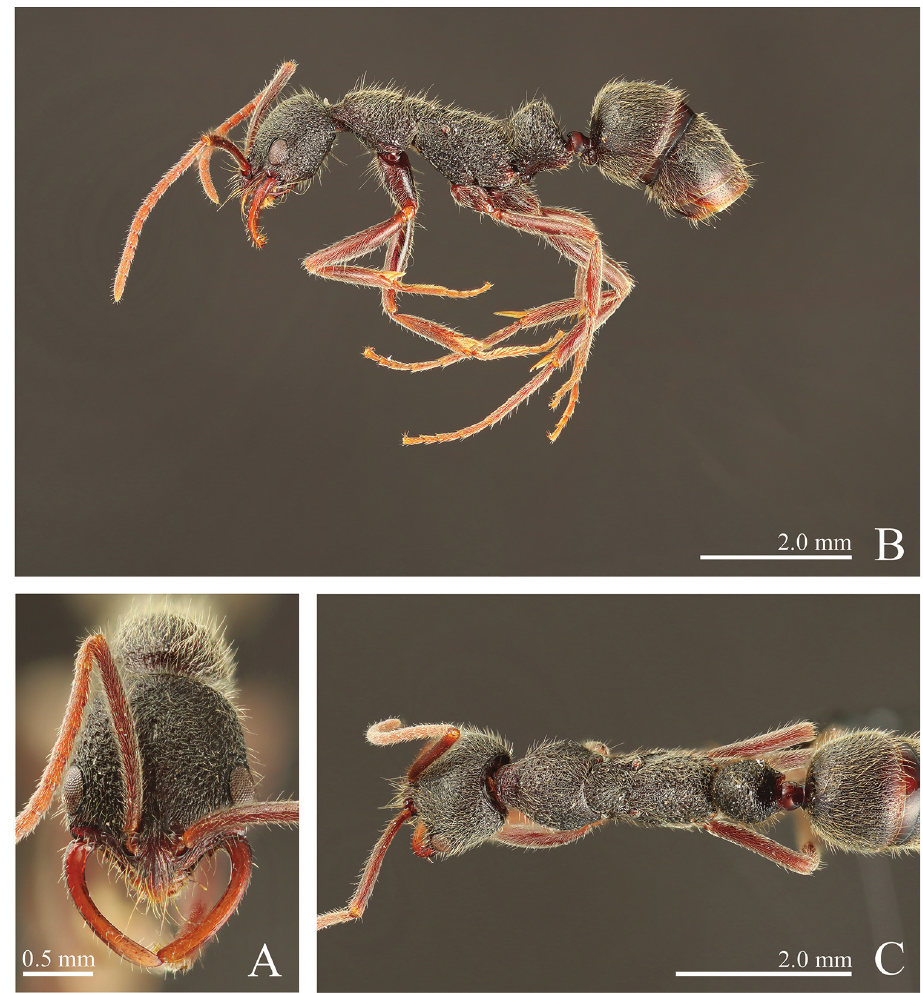
Figure 7. Leptogenys curva sp. n., paratype, queen; gastral apical two segments removed. A head, full-face view B lateral view C dorsal